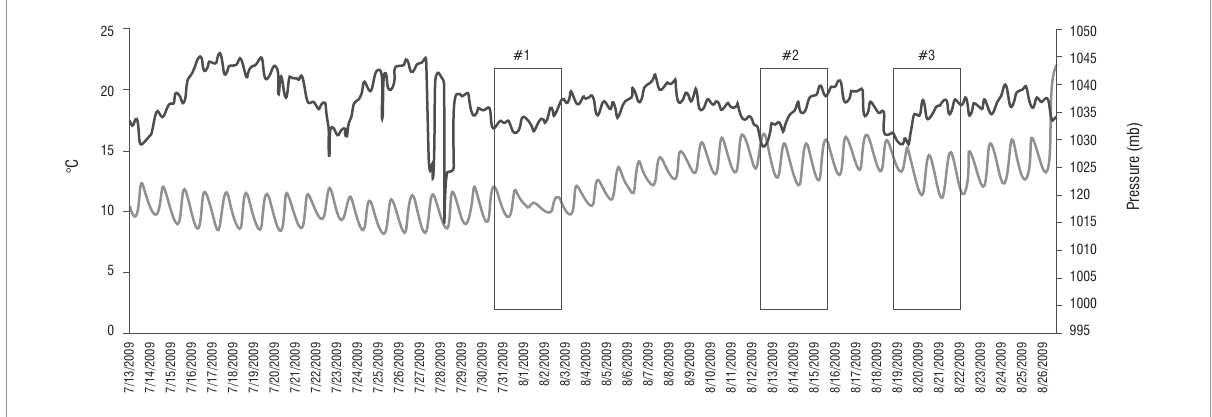
Figure 5: Graphical representation of atmospheric temperature (dark grey line) and water temperature (light grey line) (°C) and atmospheric pressure (black line) (mb) at Site 2 from 13 July 2009 to 26 August 2009. Three weather events referred to in the text are indicated: 29 July to 01 August (#1), 12 August to 14 August (#2) and 18 August to 20 August